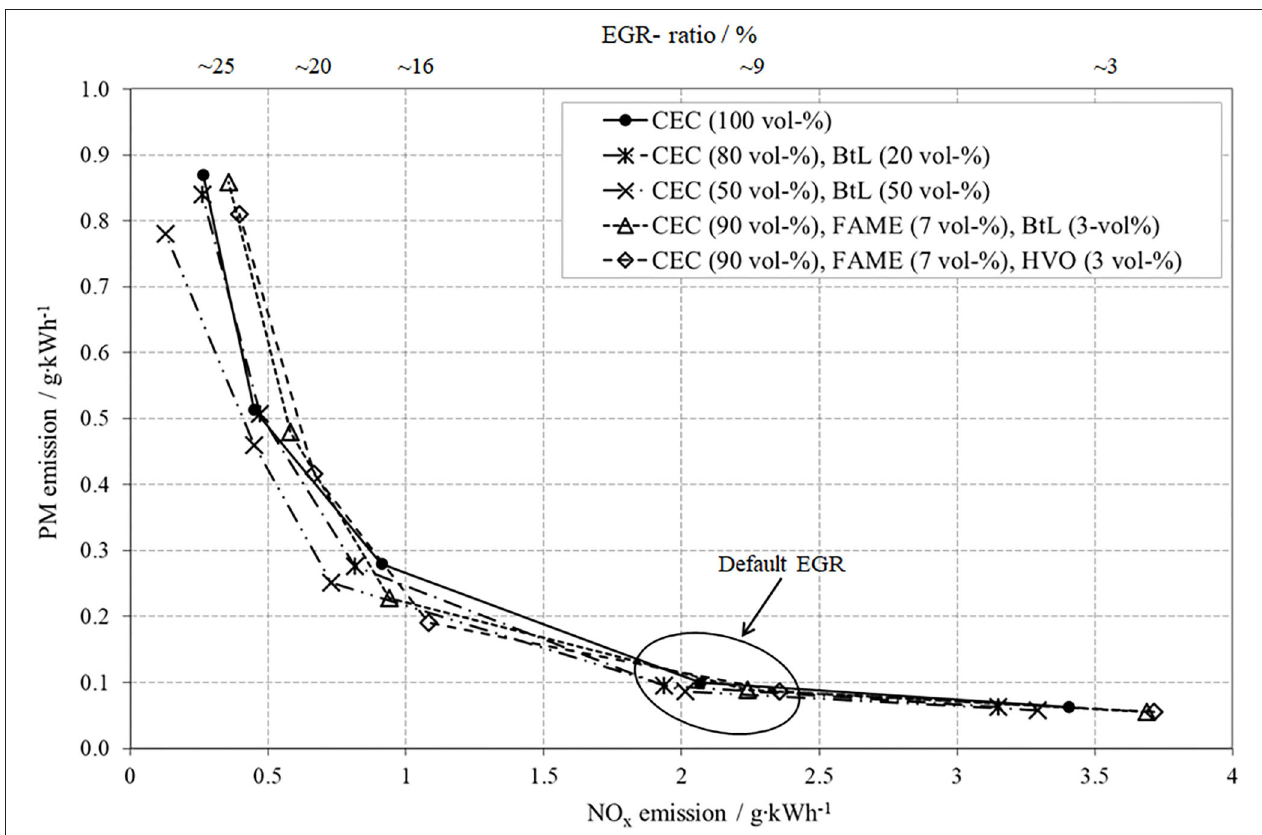
FIGURE 5 | Specific NO x - and PM-emissions at 1,500 min − 1 and 5 bar BMEP with varying